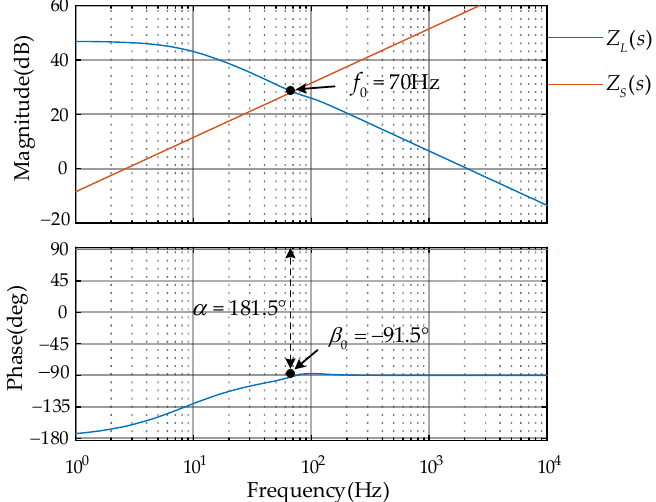
Figure 7. Bode diagram of Z S ( s ) and Z L ( s )